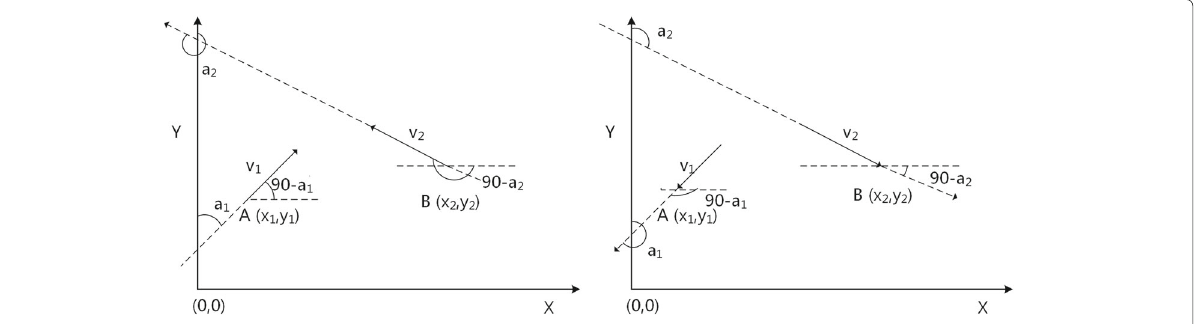
Fig. 5 Sailing states